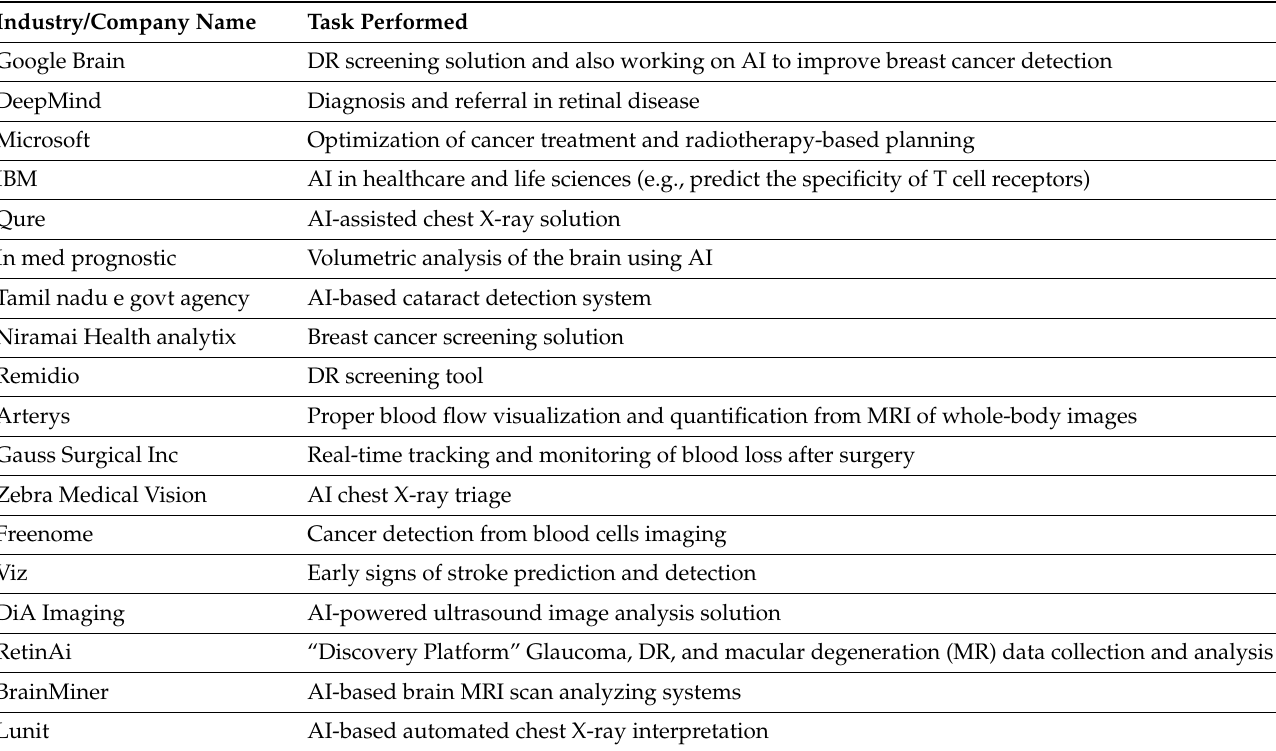
Table 1. Prominent work around the world in industry and company related to CV in medical